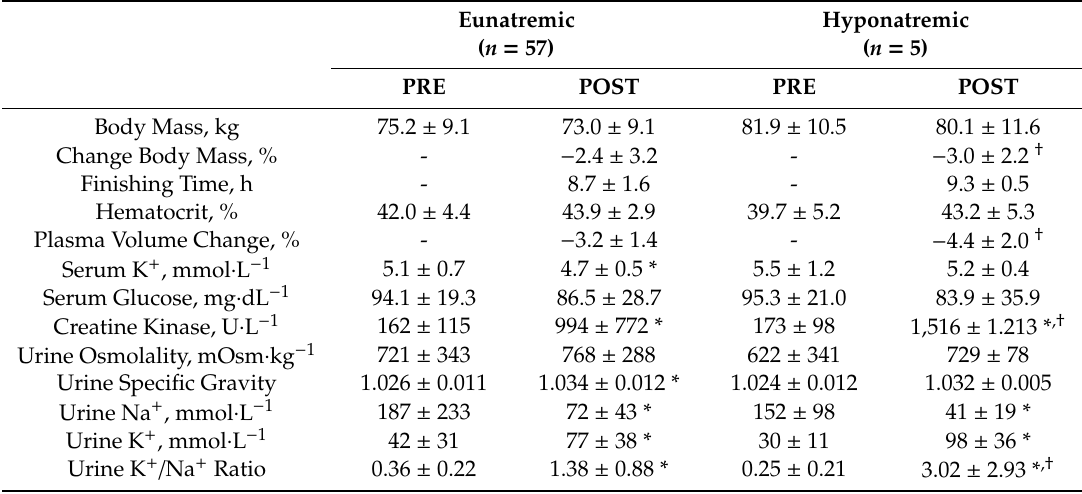
Hyponatremic ( n = 5)